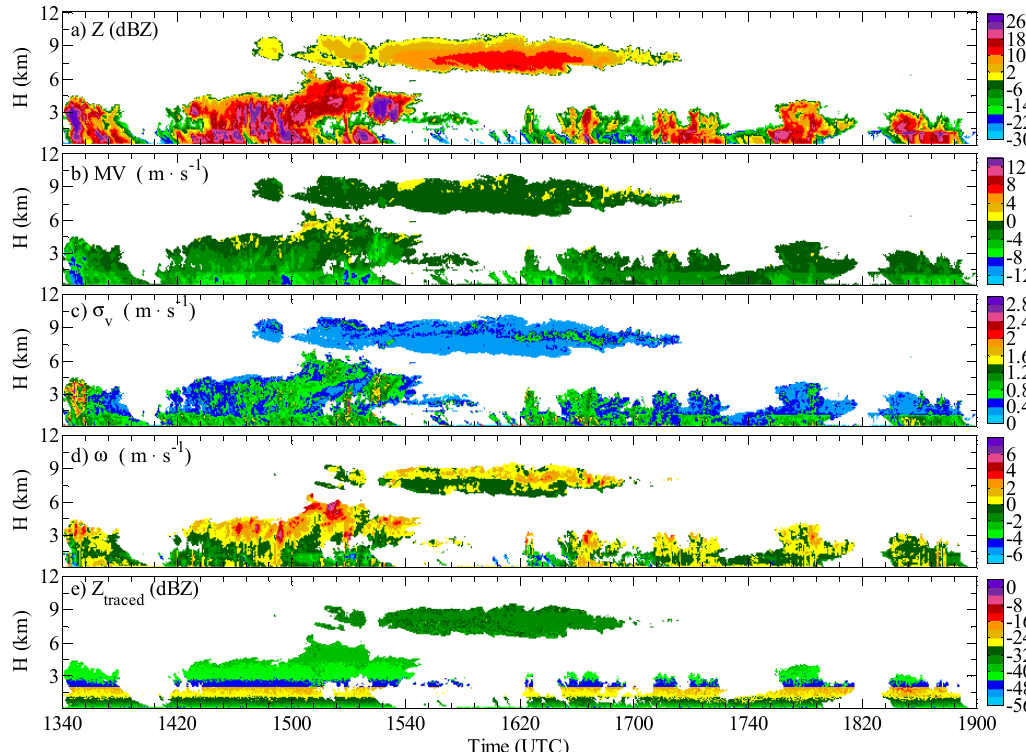
Figure 8. Cloud radar measurements and retrieval results of a light convective precipitation process collected from 13:40 to 19:00 UTC on 18 August 2015; (a) is the reflectivity; (b) is the mean Doppler velocity; (c) is the spectrum width; (d) is the vertical air velocity; (e) is the reflectivity of traced spectral bin.